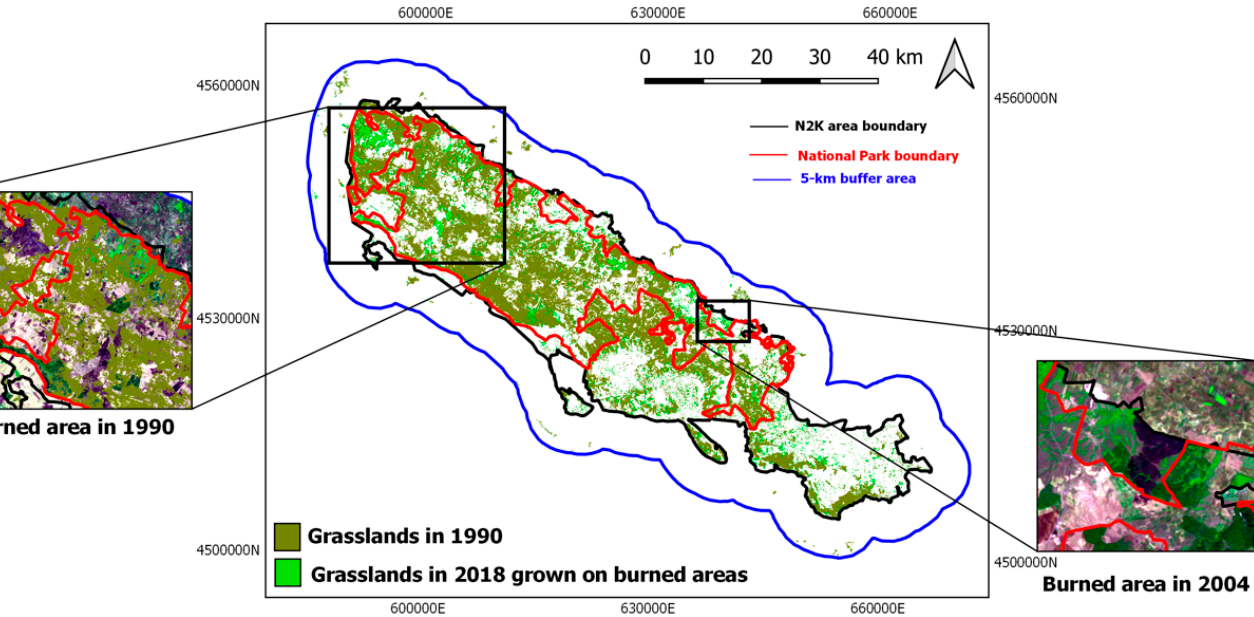
Figure 11. Grasslands mapping for 1990 overlapped on that for 2018: grasslands regrowth areas in green. In the two close-ups on the sides several burned areas can be recognized where grasslands regrowth has been mapped in